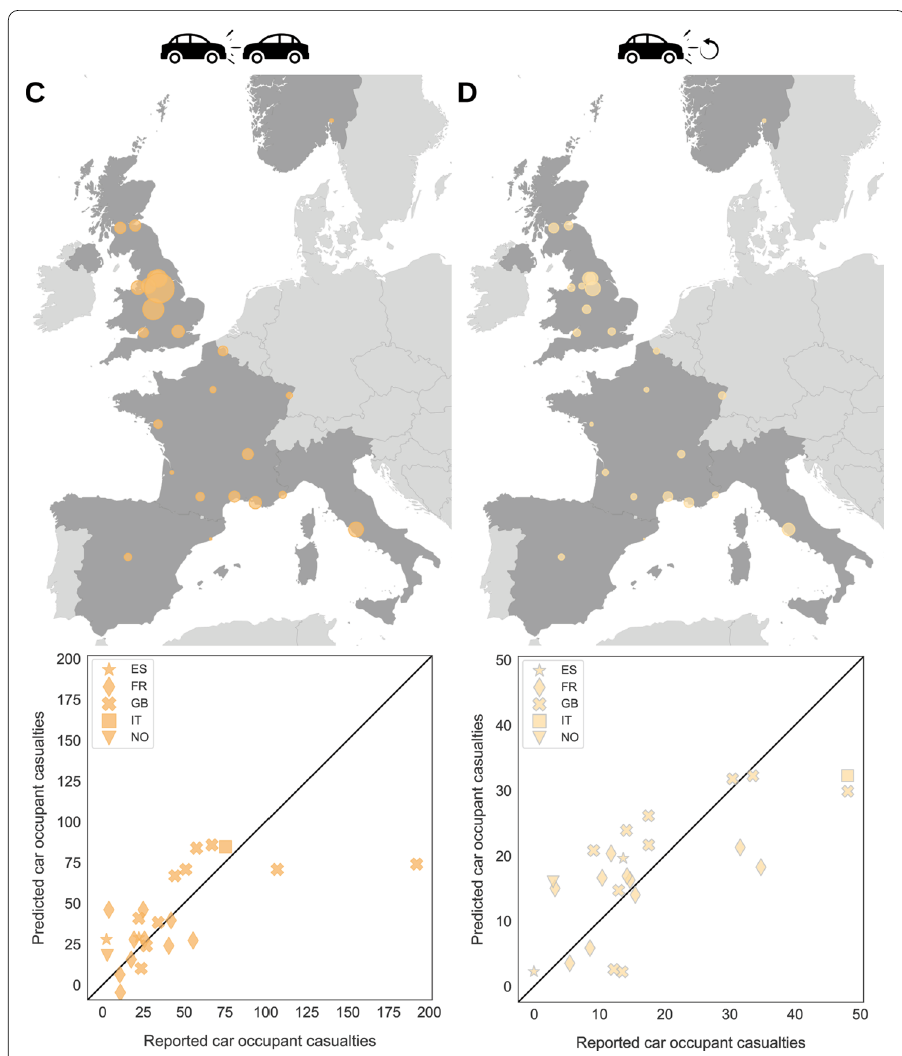
Figure 6 Collisions involving cars: maps of the collisions and performance of the models.. Maps are showing the reported numbers of car/taxi occupants killed or seriously injured in a crash among cars or in a single-vehicle crash, normalized by population. fit of the model with 2 independent covariates (see Tab. S1). Panel C (left) refers to car occupants from a car-car crash, while panel D (right) refers to those from a single-vehicle crash. Colours correspond to those seen in Fig. 3. Sheffield has the highest KSI rates among car occupants, doubling the KSI rates of Birmingham. Regression results showed adjusted R 2 = 0.36 for panel C and adjusted R 2 = 0.45 for panel